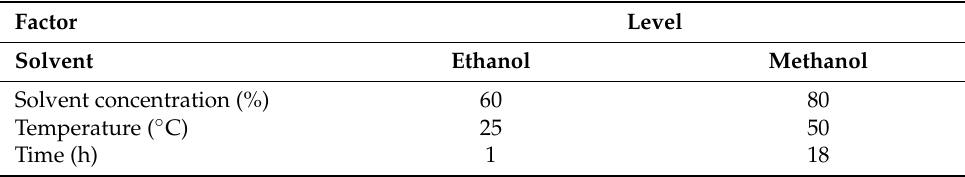
Table 1. Factorial design to select the extraction conditions of pretreated garlic